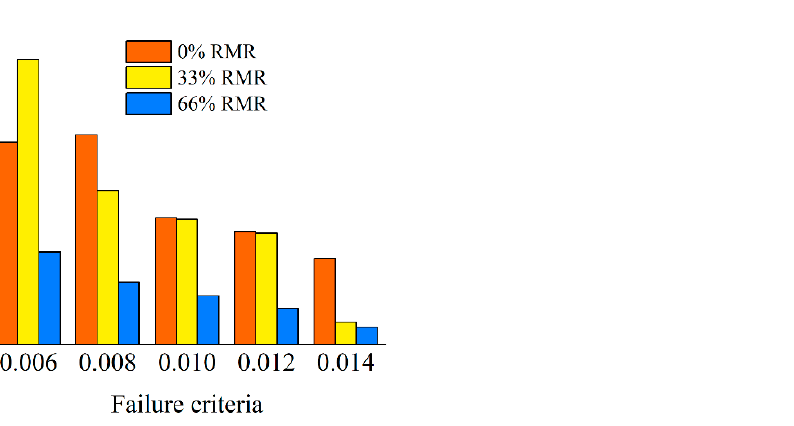
Figure 11. Relationship between failure criteria and number of deleted elements under different RMR.